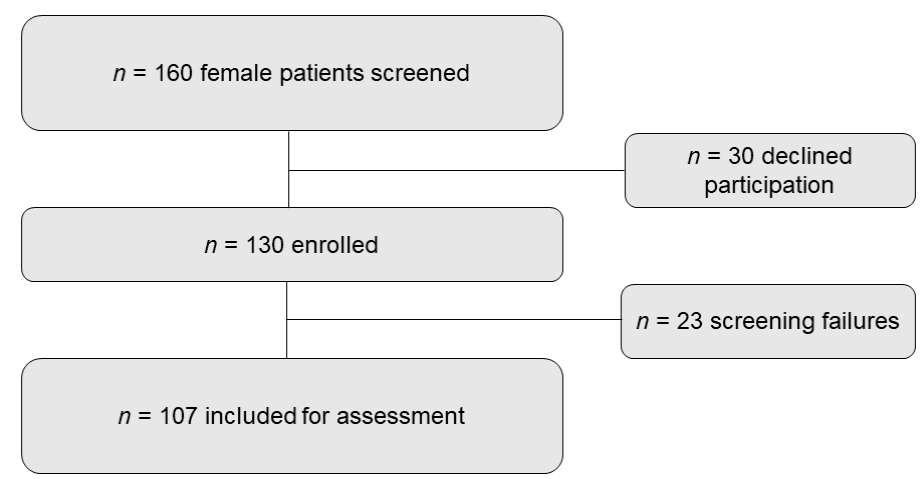
Figure 1. Flow diagram of study participants. Table 1. Baseline characteristics of the study cohort with differences between patients with ≥ 4 SARC-F and ≤ 11 MNA-SF scores.